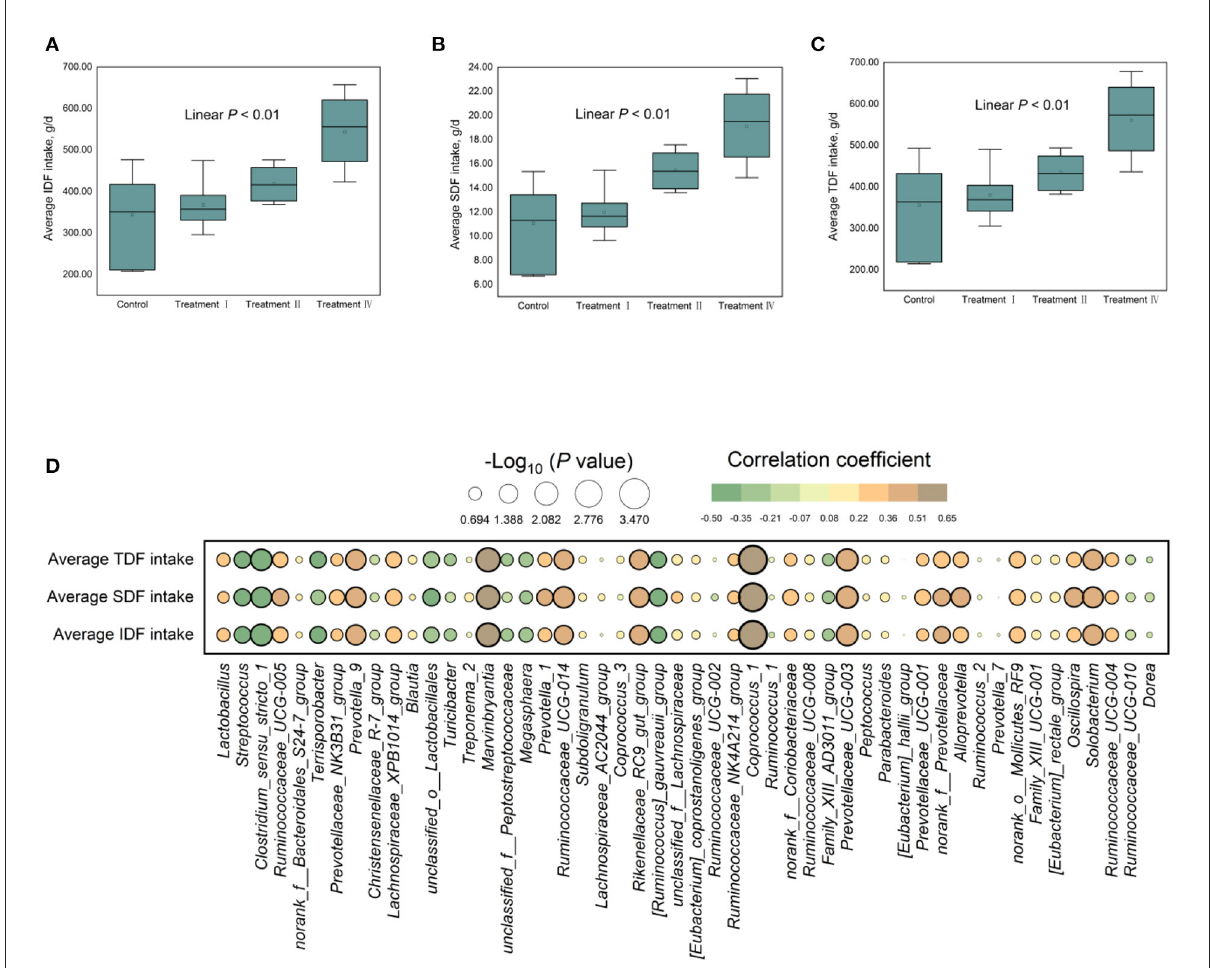
FIGURE5 (A–C) The dietary fiber intake among four groups and (D) their correlation analysis with microbiota (Top